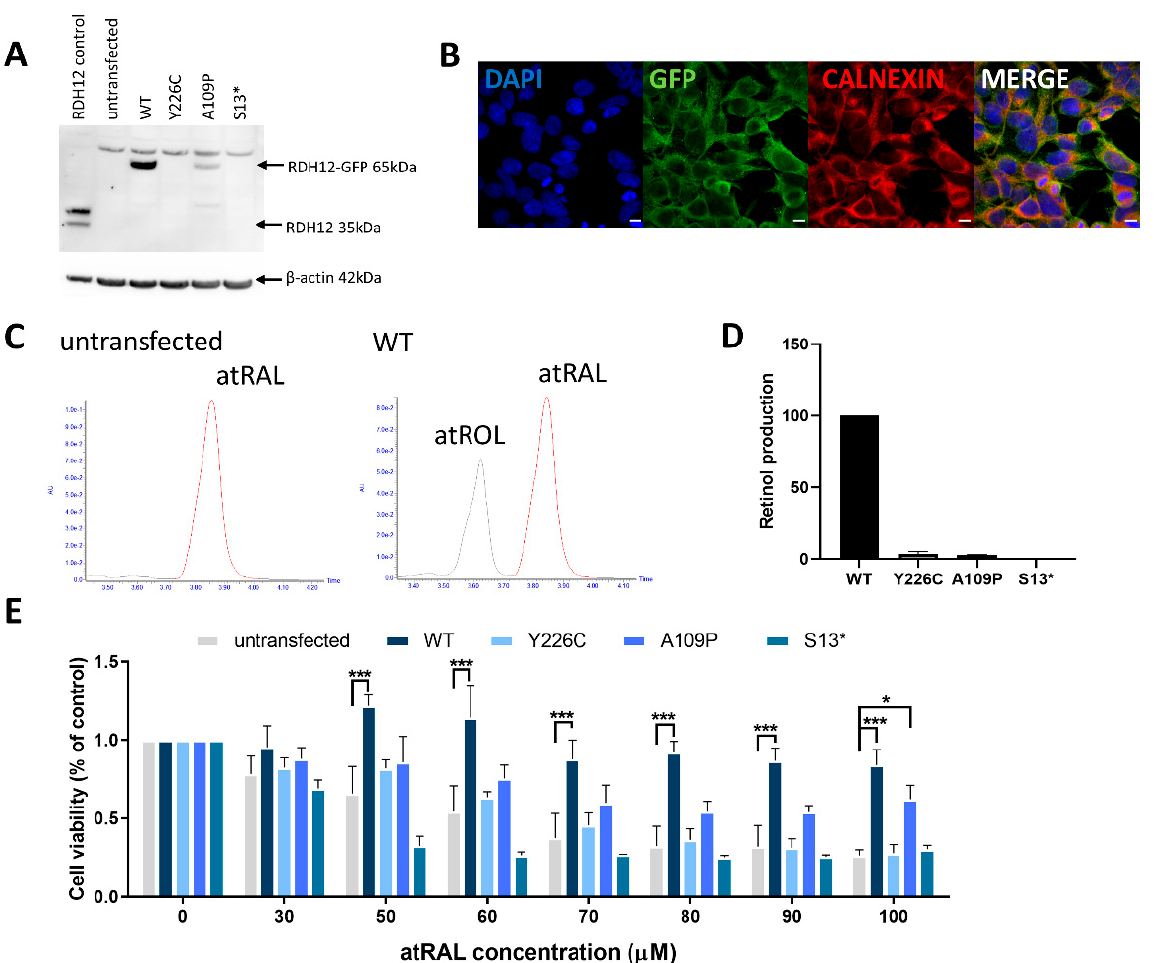
Figure 1. Generation of HEK-293 stable cell line expressing wildtype and mutant RDH12. ( A ) Western blot analysis of HEK-293 cells transfected with GFP-tagged RDH12. p.Y226C and p.S13* cell lines show no RDH12 protein expression, while p.A109P shows reduced expression. ( B ) Co-staining of calnexin (red) and GFP (green) confirmed localisation of RDH12 to the endoplasmic reticulum. Nuclei were counterstained with DAPI (4 (cid:48) ,6-diamidino-2-phenylindole) (blue). Scale bar = 10 µ M. ( C ) RDH12 activity assay using HPLC showed no atROL was detected in untransfected cells, but it was found in WT cells, confirming active functional RDH12. ( D ) Enzyme activity of all mutant proteins was significantly reduced compared with WT RDH12. ( E ) RDH12 protects against atRAL-induced toxicity. Cells were dosed with increasing concentrations of atRAL for 24 h and cell viability was assessed by MTT assay. atRAL is toxic to untransfected cells, whereas cells expressing WT RDH12 were protected from atRAL-induced cell death. p.Y226C and p.S13* mutant RDH12 did not protect cells from atRAL toxicity, whereas p.A109P mutant protein offered significantly higher protection than untransfected cells at 100 µ M atRAL concentration. Three independent experiments were performed. Data are expressed as mean ± SEM, and analysed using two-way ANOVA, followed by Dunnetts multiple comparison test. * p ≤ 0.05, *** p ≤ 0.001.